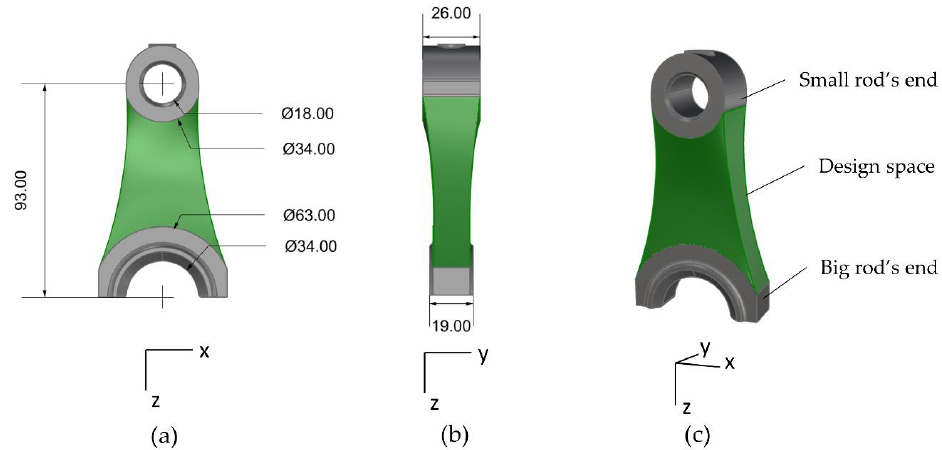
Figure 1. Front view ( a ), side view ( b ), and perspective view ( c ) of the piston